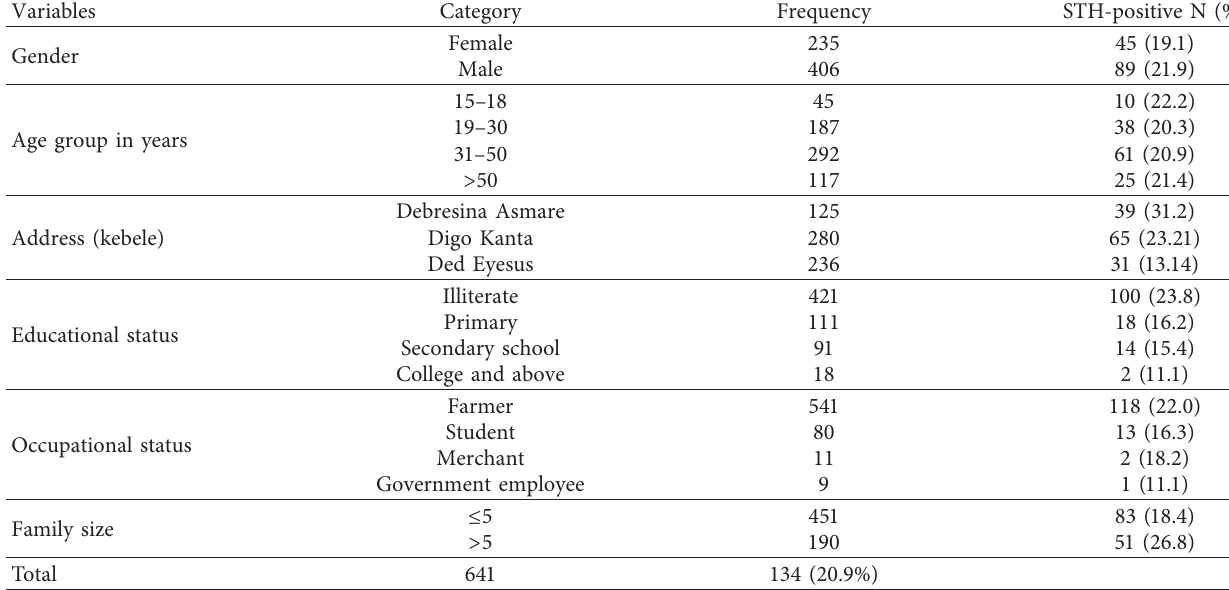
Table 2: Prevalence of STH infections in adolescents and adults ( n � 641) by sociodemographic factors in Bibugn Woreda, East Gojjam, Ethiopia, from February to September 2021.